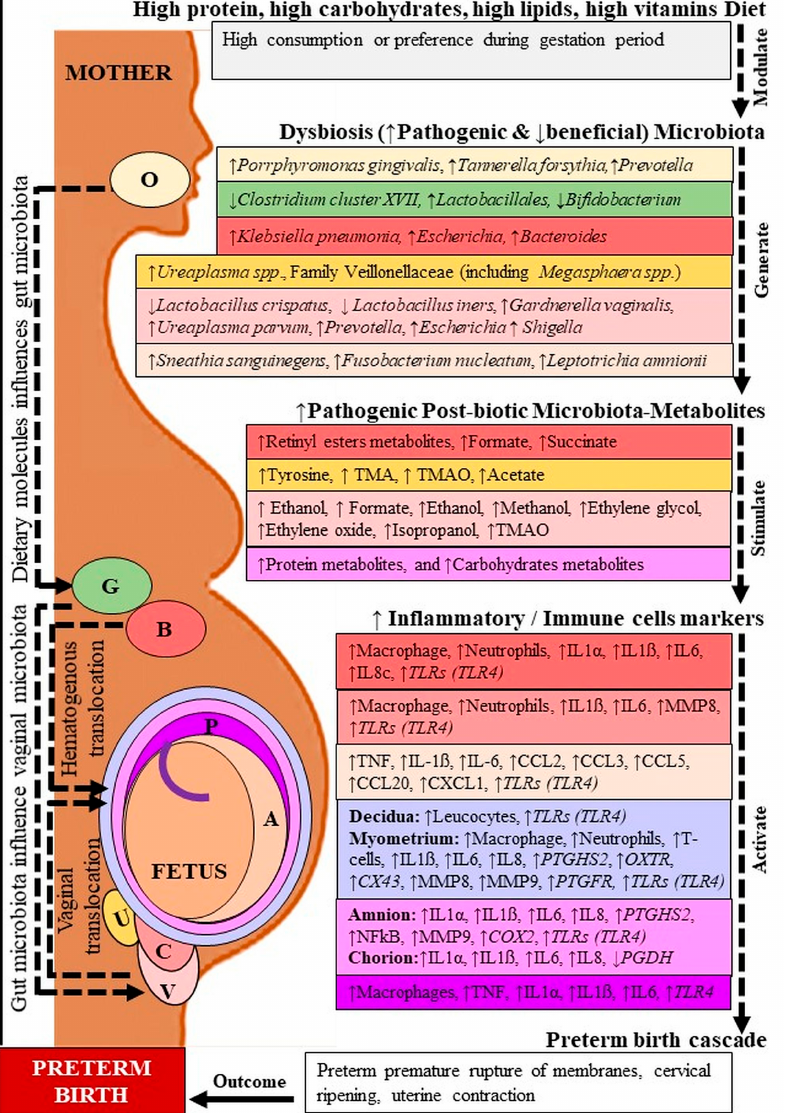
Figure 1. Microbiota-metabolites and inflammatory markers in preterm birth. O: Oral; G: Gut; B: Blood; U: Urine; V: Vagina; C: Cervix; P: Placenta; A: Amniotic fluid. TMA: Trimethylamine, TMAO: Trimethylamine N-oxide; IL: Interleukin; TNF: Tumor necrosis factor; MMP: Matrix metallopro- teinase; CCL: C-C motif chemokine ligand; CXCL: C-X-C motif chemokine; PTGDS2 : Prostaglandin D2 synthase; OXTR : Oxytocin receptor; CX : Connexin; NFkB : Nuclear factor-kappa B; COX : Cy- clooxygenase; PGDH : Prostaglandin dehydrogenase. Dashed lines indicate several steps, ↓ decreased, ↑ increased level. Location followed by color